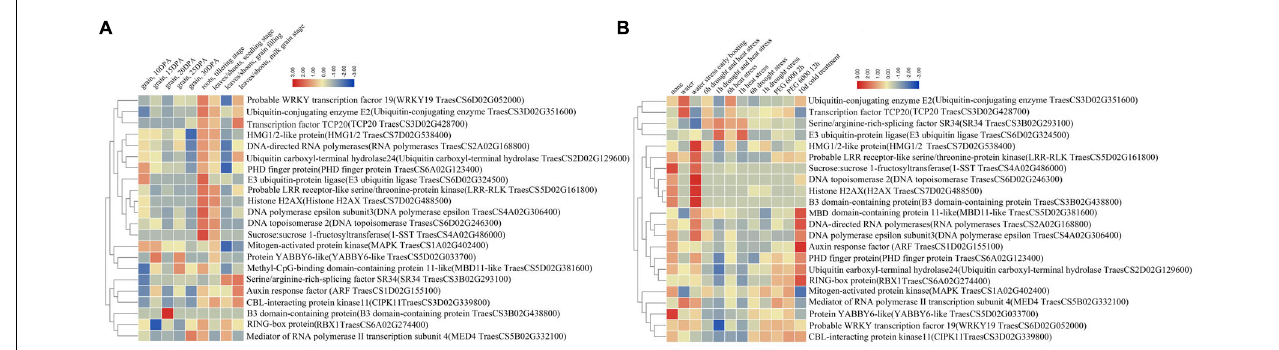
FIGURE 4 | The relative expression profiles of the 38 up-regulated nuclear differentially accumulated proteins (DAPs) encoding genes. (A) In different development period of wheat different organs. (B) Different abiotic stresses. Red means high expression level, green means low expression level.